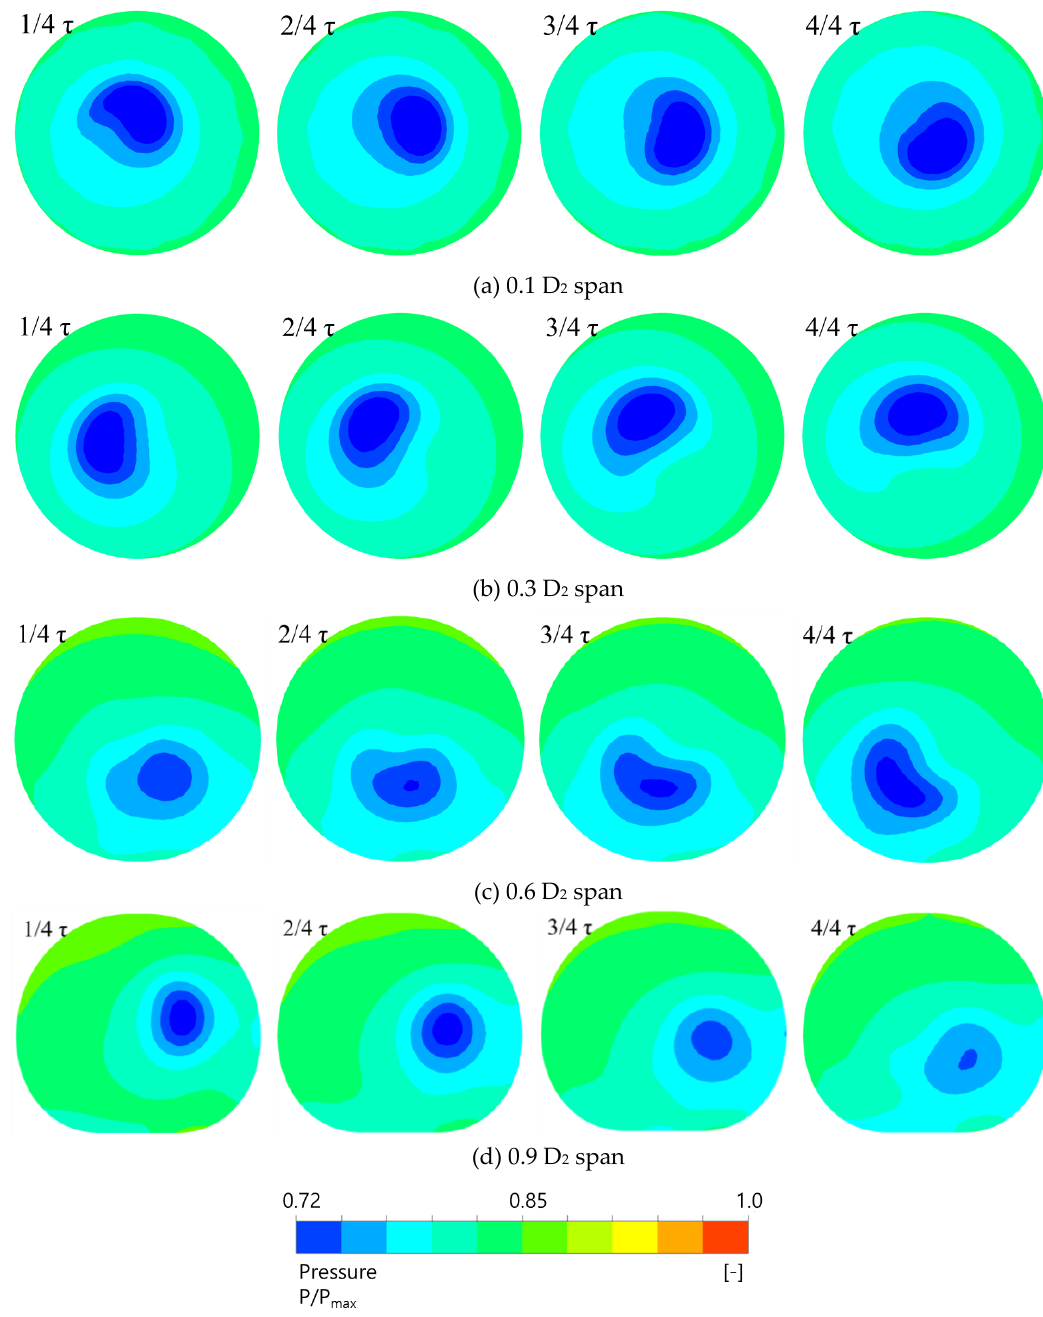
Figure 15. Pressure distributions on observed spans in the DT without anti-cavity fins at the GV at 16 ◦ during one revolution of the runner: span locations at ( a ) 0.1, ( b ) 0.3, ( c ) 0.6, and ( d ) 0.9 D 2 .